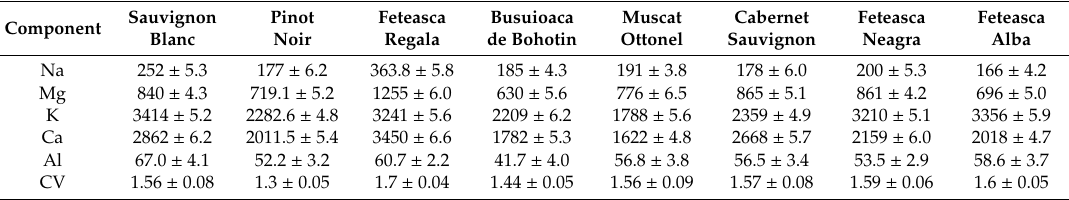
Table 5. Metals (mg kg − 1 ) content and calorific value (CV, MJ kg − 1 ) of vine-shoot waste variety (data represents mean ± standard deviation, n = 3 parallel measurement).